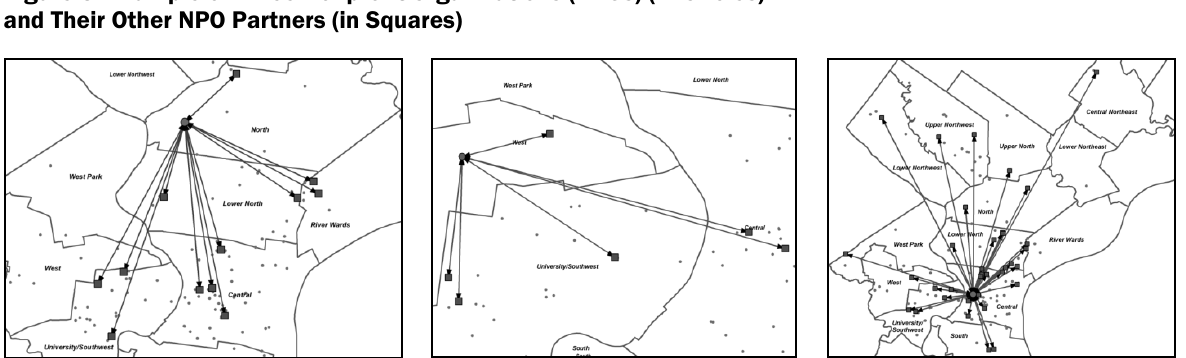
Figure 5. Example of Three Nonprofit Organizations (NPOs) (in Circles) and Their Other NPO Partners (in